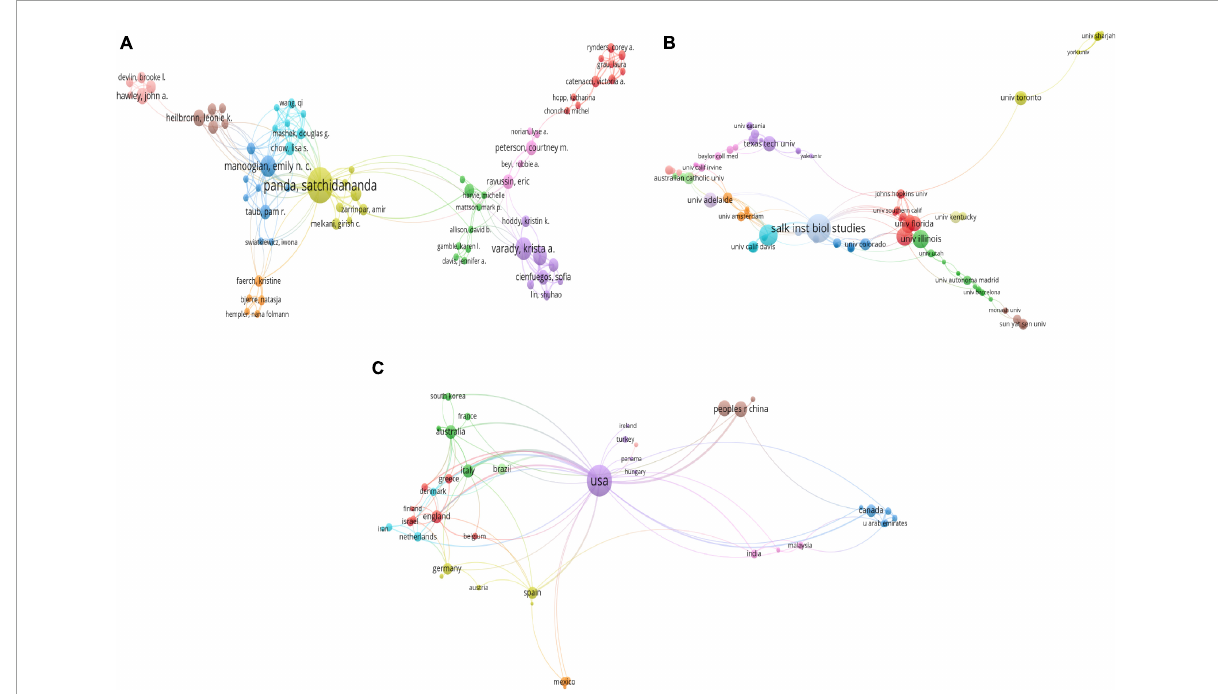
FIGURE3 Visualization knowledge maps of the co-authorship. (A) The co-authorship map of authors which indicates the authors that cooperate in the field of time-restricted eating (TRE); (B) the co-authorship map of organizations. Salk Institute for Biological Studies has published the most related papers (24 items); (C) the co-authorship map of countries. The number of collaborators with United States is 184 and the total link strength is 114. Different colors indicate different clusters and the size of nodes indicates the number of publications. The thickness of the lines represents the link strength of the